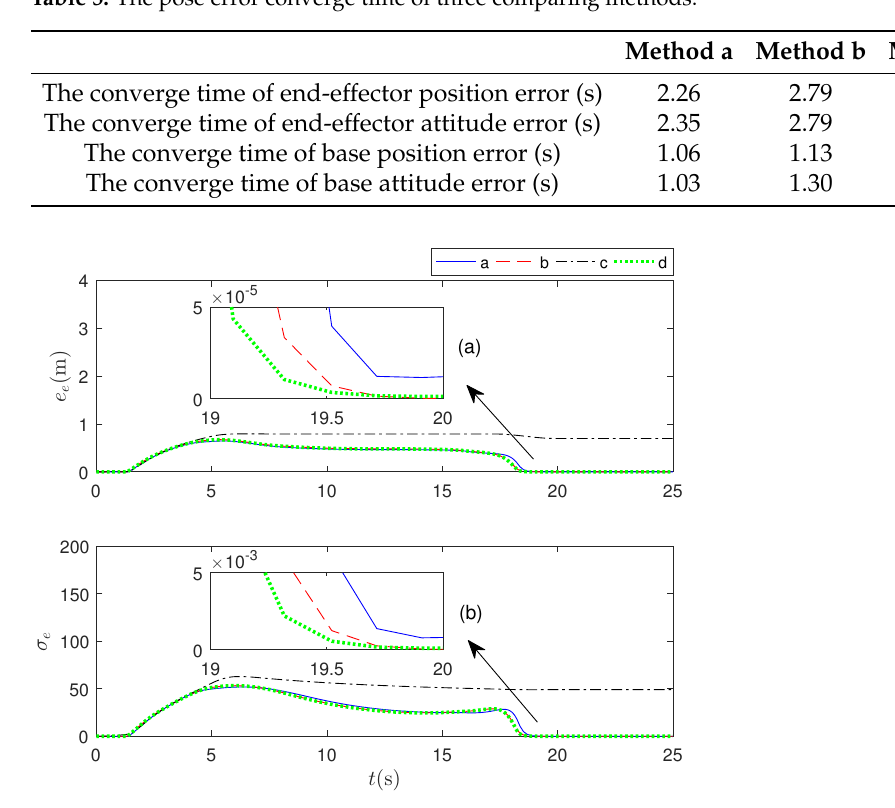
Figure 6. The pose errors of end-effector in four methods (three axis synthesis).